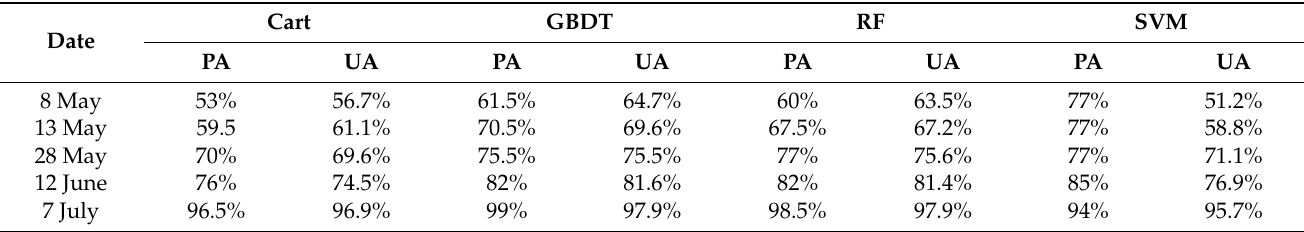
Table 9. Maximum PA and UA of soybeans in 2020 different